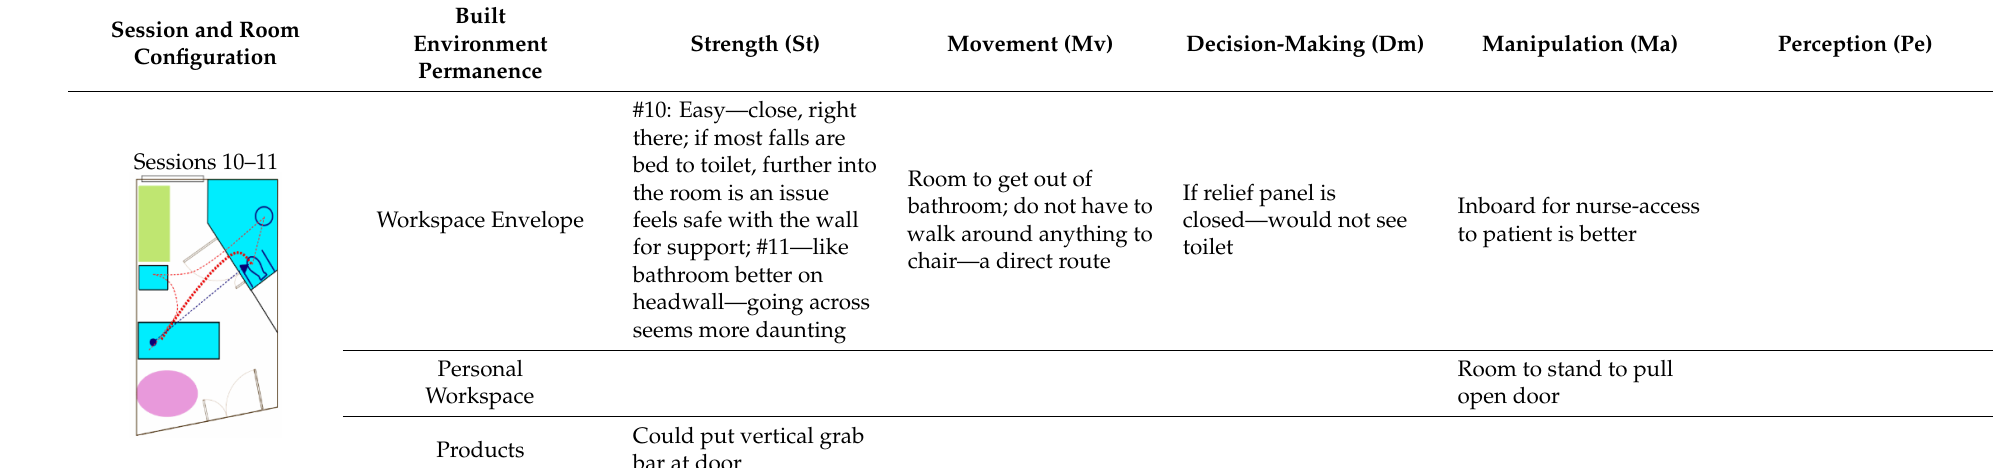
Table 6. Session 10–11 Feedback (Room 5—Outboard